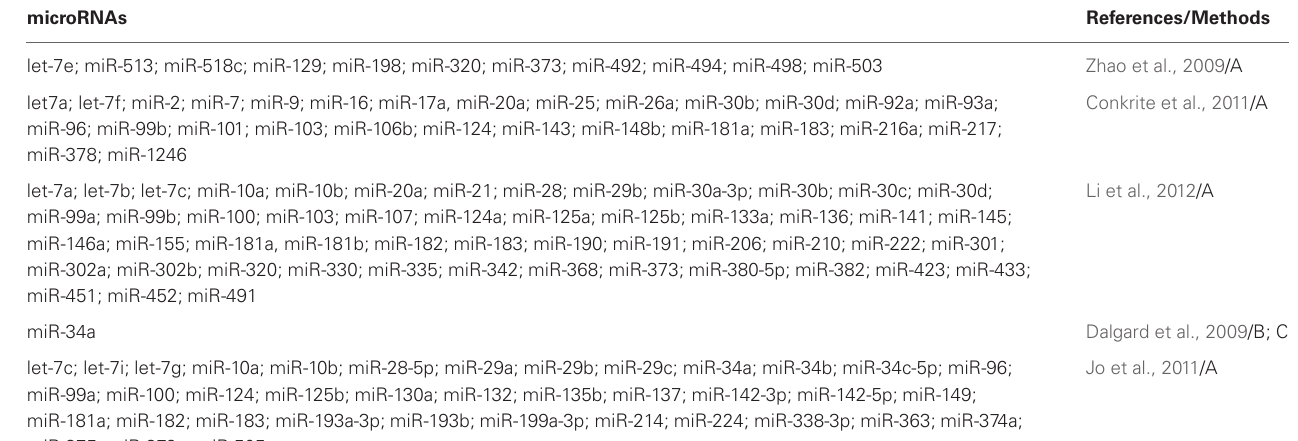
Table 1 | microRNAs that are differentially expressed in human retinoblastoma.